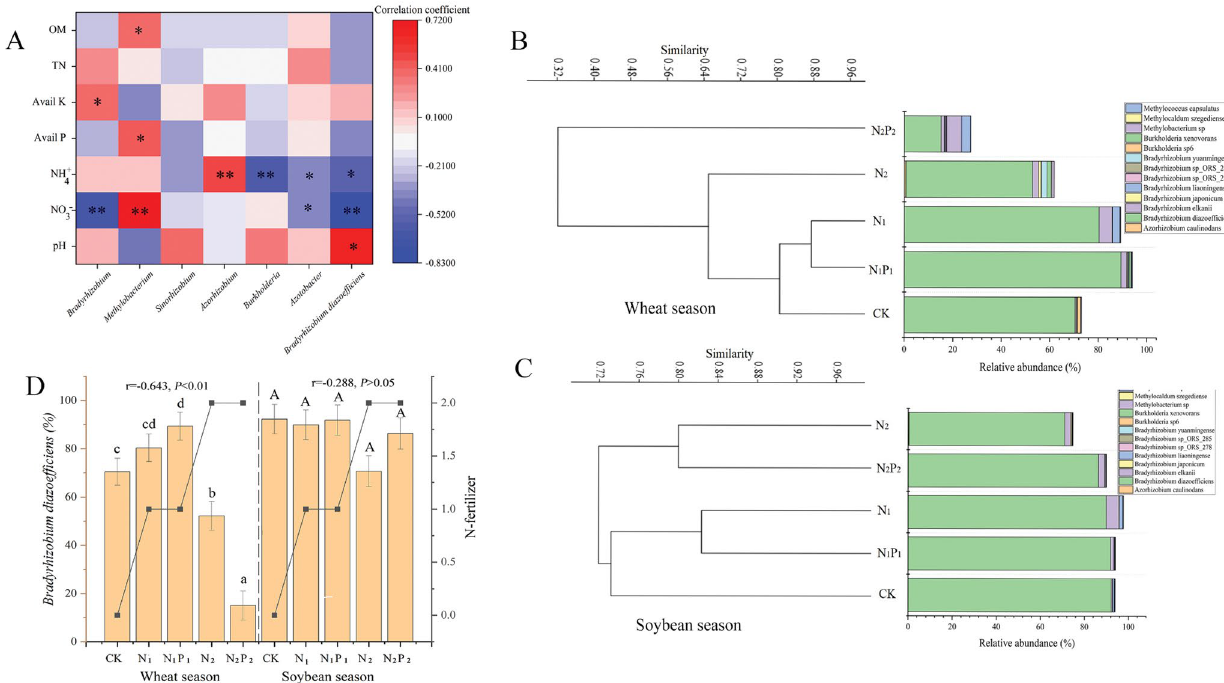
Figure 4. Correlation and cluster analysis at the species level. ( A ) Correlationships between microbial abundance, genera belonging to rhizobia and soil chemical properties. ( B , C ) show the results of clustering analysis based on rhizobia (at the species level) in soils of the wheat and soybean seasons, respectively. ( D ) Shows the relative abundance of Bradyrhizobium diazoefficiens in soil samples and their correlation with N fertilizer. W soil samples in the wheat season, S soil samples in the soybean